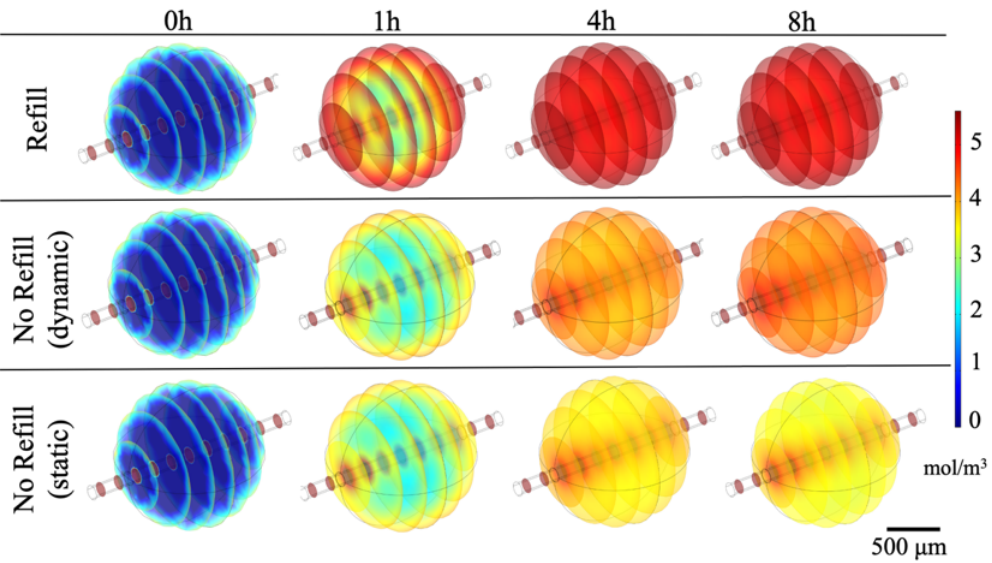
Figure 5. Glucose concentration within fibrin hydrogels modeled simulating three different scenarios: (i) continuous culture medium refilling, (ii) dynamic no culture medium refilling, (iii) static no culture medium refilling within the chamber. Four different time points are reported: t 0 = 0 h, t 1 = 1 h, t 2 = 4 h, t 3 = 8 h.